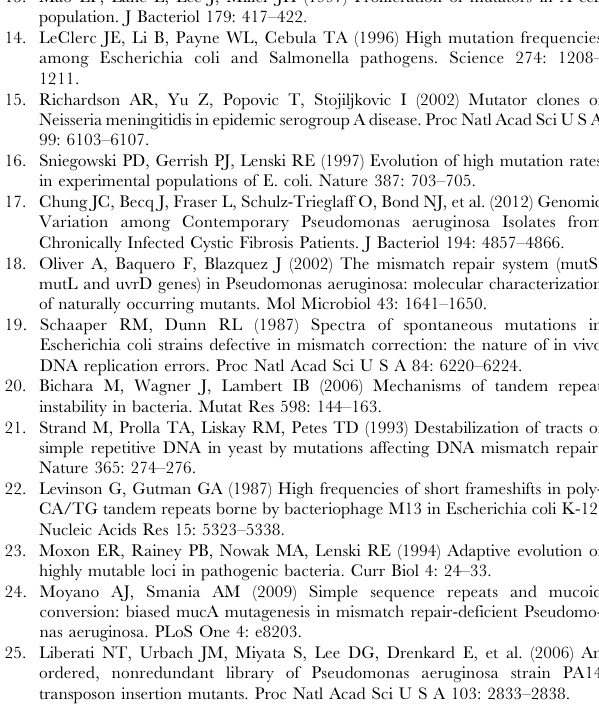
Table S1 Prevalence of homopolymers in essential genes and genes functionally related to the composition of the cell envelope. Table S2 Full list of pathoadaptive genes (n= 65). Table S3 Non-synonymous mutations in genes rpoB , gyrA and gyrB . For each of the mutations, we have listed studies of our knowledge to have shown or indicated the specific mutation to confer resistance against an antibiotic. Table S4 List of sequenced samples and corresponding Sequence Read Archive (SRA) accession numbers. Table S5 Full list of SNPs. Table S6 Full list of